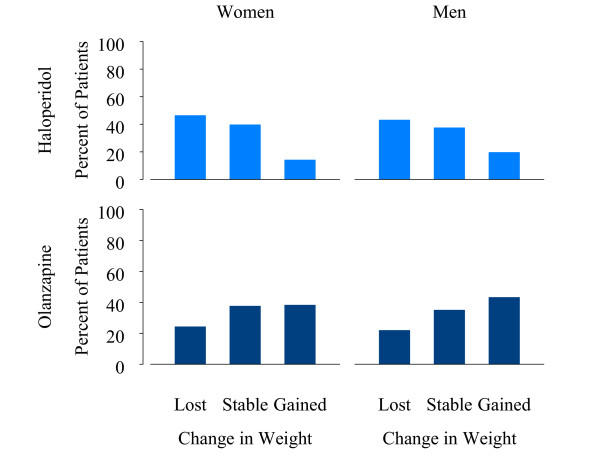
Percentage of patients with different levels of weight change by gender and medication. Patients were placed in 3 equal groups based on their percent change in weight: "Lost" indicates any weight loss, "Stable" indicates ≥ 0% to <3% weight gain, and "Gained" indicates ≥ 3% weight gain. Olanzapine treatment group (N = 1337; 870 men, 467 women); Haloperidol treatment group (N = 659, 426 men, 233 women).